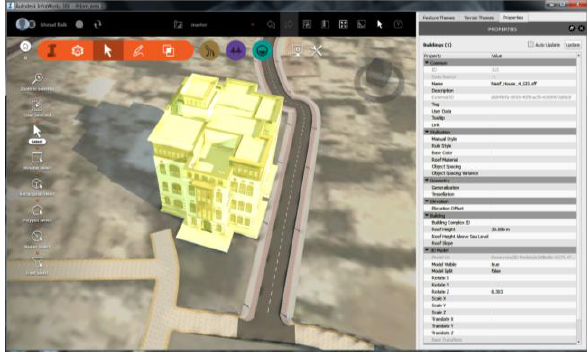
Figure 12: Descriptive attribute data of Nasif Historical House in Autodesk InfraWorks